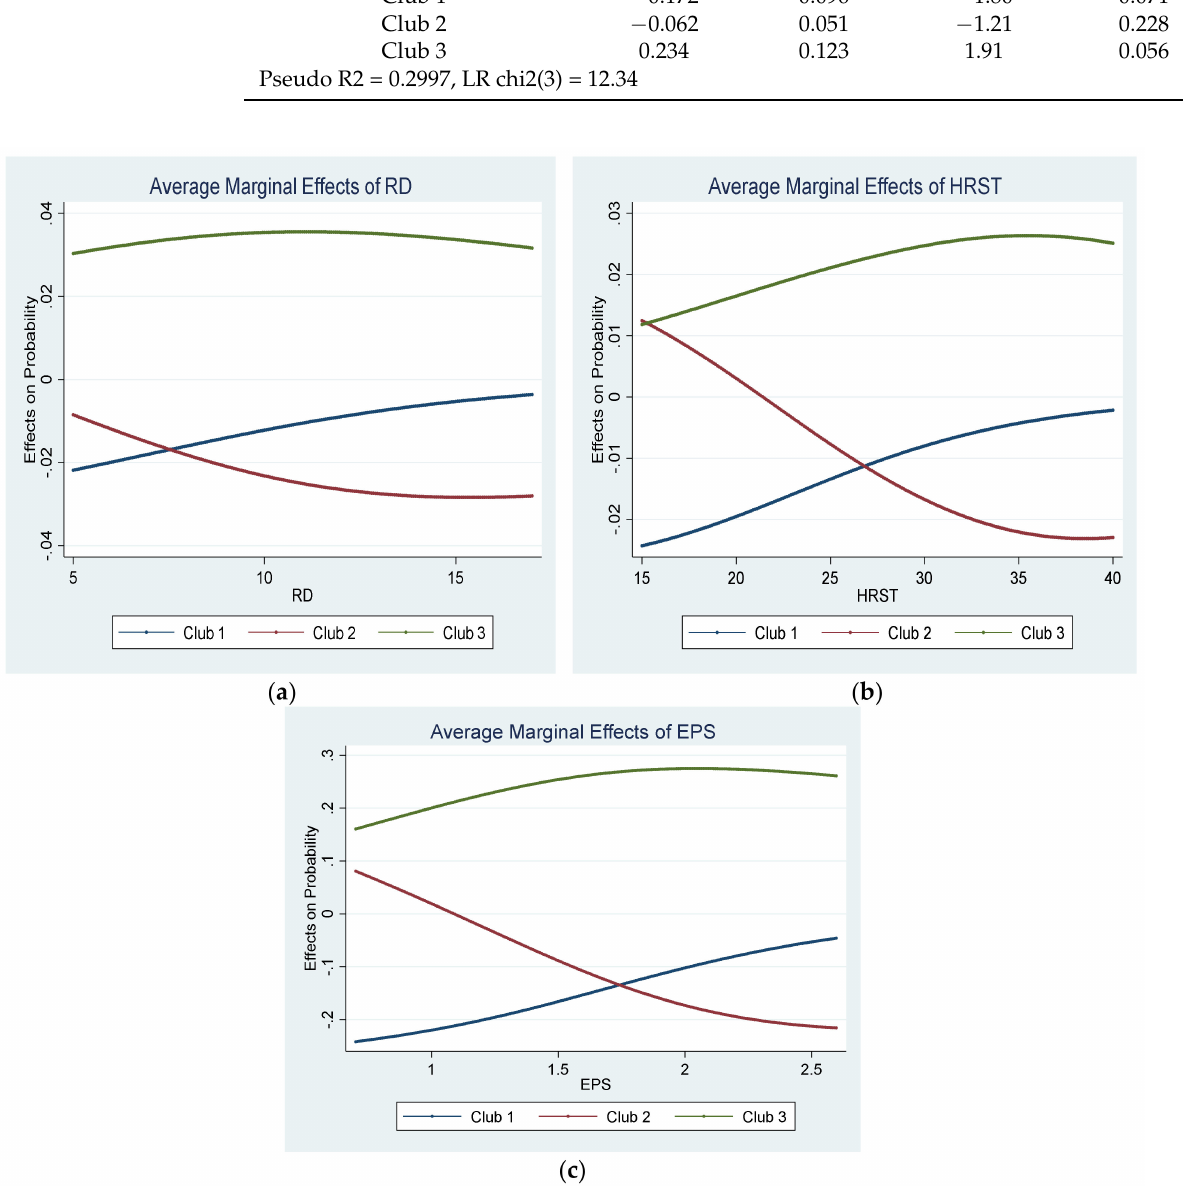
Figure 3. Changes of marginal effects: ( a ) Marginal effects of RD; ( b ) Marginal effects of HRST; ( c ) Marginal effects of